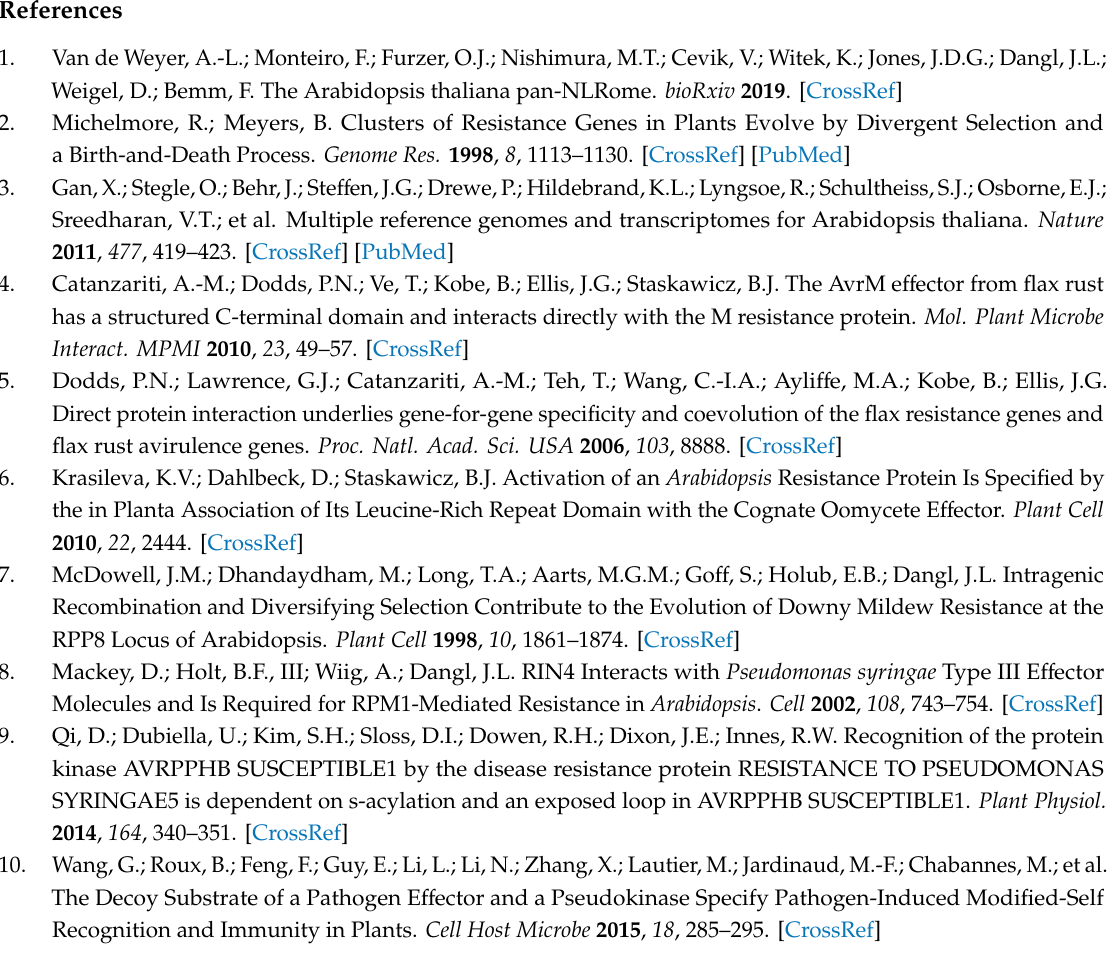
population, Table S7: R 2 values for linear models of the correlation in SNP frequencies for shared polymorphisms in the sequenced duplicated